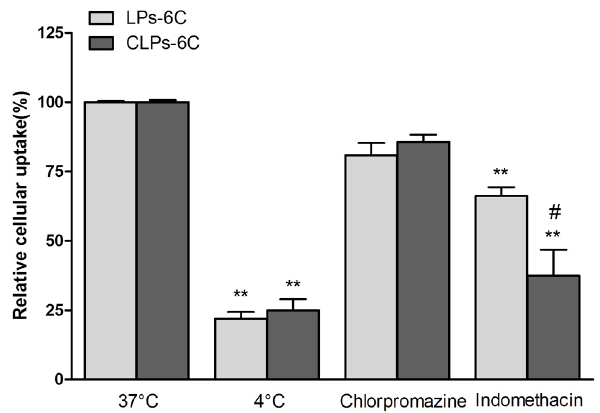
Figure 7. Effect of the temperature (4 °C) and different inhibitors on hCMEC/D3 cell internalization pathways of LPs-6C and CLPs-6C after 2 h incubation at 37 °C. (Data represent the mean ± standard deviation ( n = 3). Bars represent the mean ± SD of at least 6 experiments ** p < 0.01 vs. corresponding liposome at 37 °C; # p < 0.05 CLPs-6C vs. LPs-6C. (ANOVA + Tukey’s test).